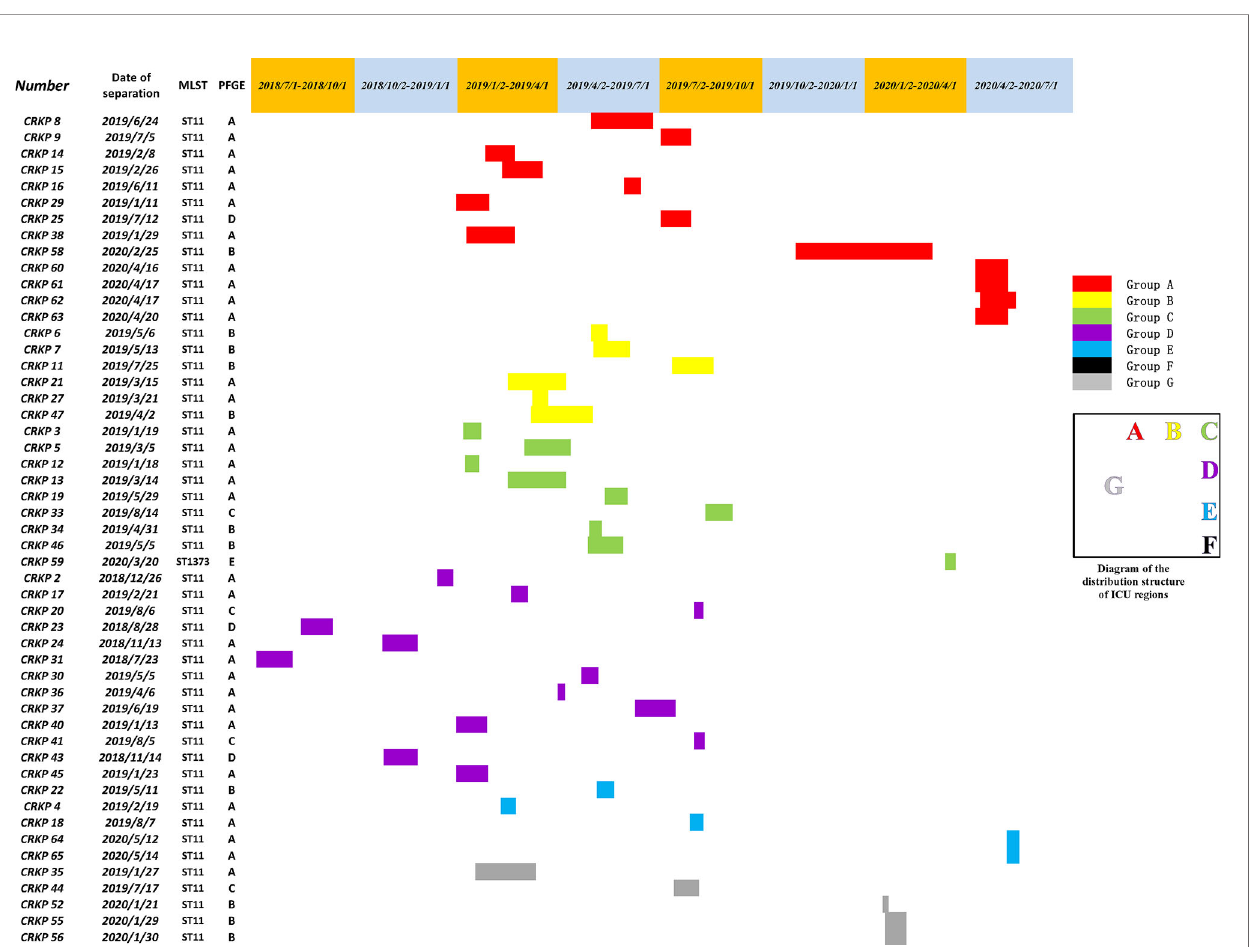
FIGURE 5 | A timeline represents the ICU stay of patients. Different colors in the legend indicate the different groups.